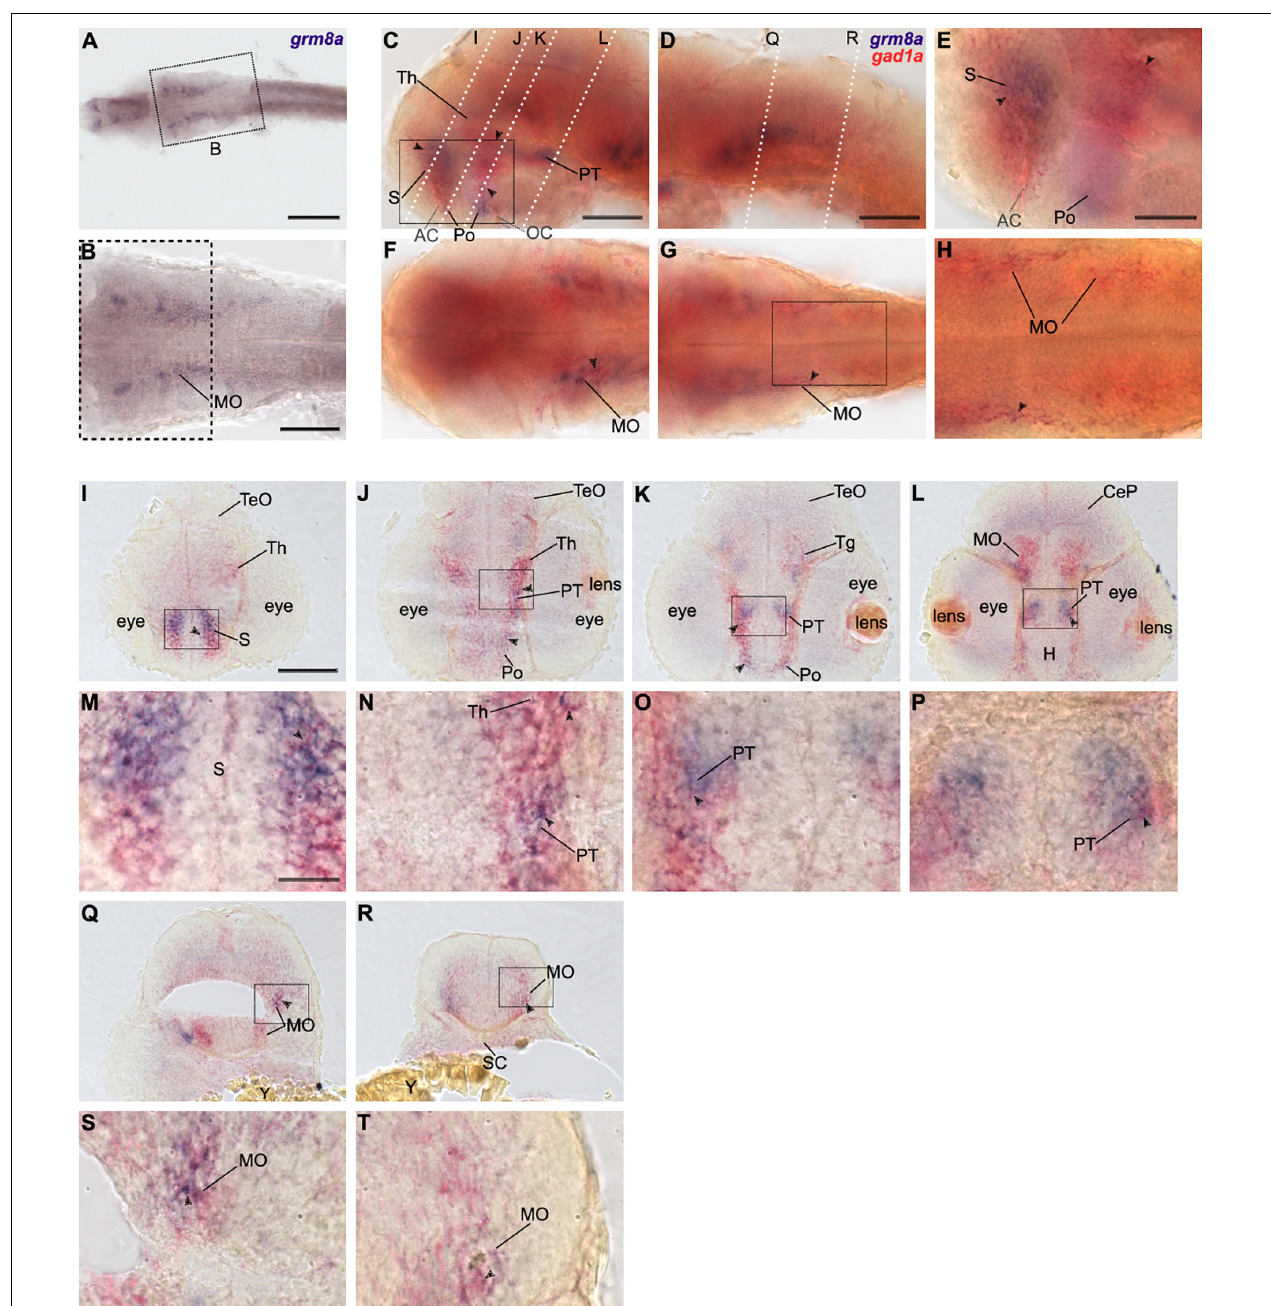
FIGURE 4 | Grm8a is partly expressed in gad1a positive neurons in the developing zebrafish brain. (A) Whole-mount RNA in situ hybridization of grm8a expression at 36 hpf. (B) Magnified picture of the region boxed in (A) . Scale bar, 200 µ m (overview) and 100 µ m (magnification). (C–T) Double labeling of grm8a (blue) and gad1a (red) expression in 36 hpf old embryos using two-color RNA in situ hybridization. Lateral (C,D) and dorsal (F,G) overview of embryonic CNS with anterior to the left. (E,H) Magnifications of boxed areas in (C,G) . Dashed lines in (C,D) indicate cutting sites for cross sections shown in (I–R) . (M–P,S,T) Magnifications of boxed areas in (I–L,Q,R) , respectively. Arrowheads indicate sites of co-localization. Abbreviations are listed in Table 1 . Scale bars: 100 µ m (overview), 50 µ m (magnified images).